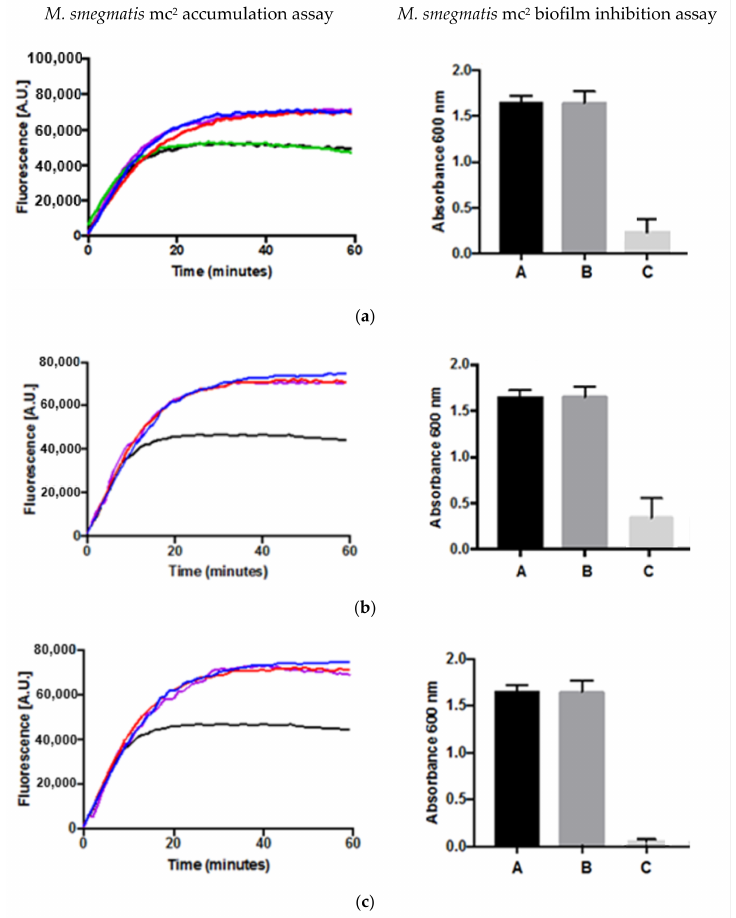
Figure 2. Inhibitory activities by compound ( a ) 1 , ( b ) 2 and ( c ) 4 in both the accumulation (left) using 3 replicates (coe ffi cient of variation, cv < 1) and biofilm formation (right ) using 6 replicates ( p -value < 0.01)assays. Blueline: verapamil(0.5 × MIC)—A—negativecontrol; Redline: chlorpromazine 0.5 × MIC—B—DMSO; Green line: compound with no known activity (0.5 × MIC)—C—0.5 × MIC; Purple line: compound tested for activity (0.5 × MIC); Black line: drug-free